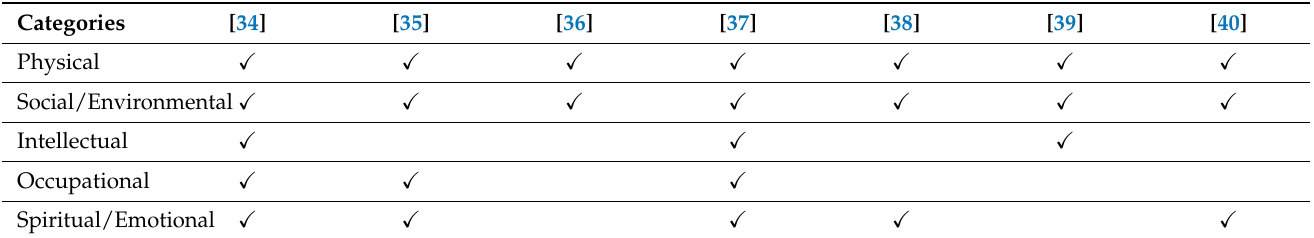
Table 1. Wellness